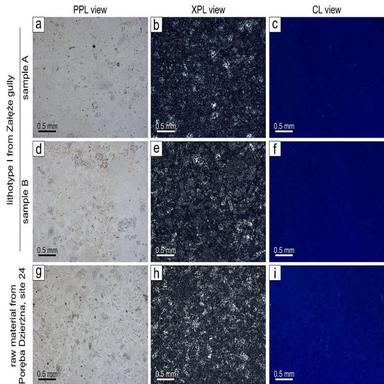
Microscopic properties of tabular chocolate flint from two deposits in KCU: the Załęze ˙ gully and the flint mine in Udorka Valley. (a-c) Lithotype I, sample A from Załęze ˙ gully; (d-f) Lithotype I, sample B from Załęze ˙ gully; (g-i) Raw material from the chocolate flint mine in Udorka Valley, Poręba Dzierzna, ˙ site 24.